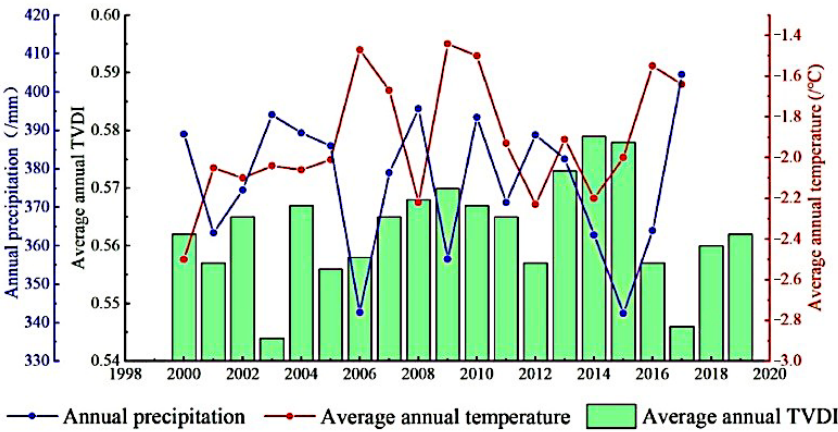
Figure 11. Changes in annual precipitation, average annual temperature and average annual TVDI of the QTP.